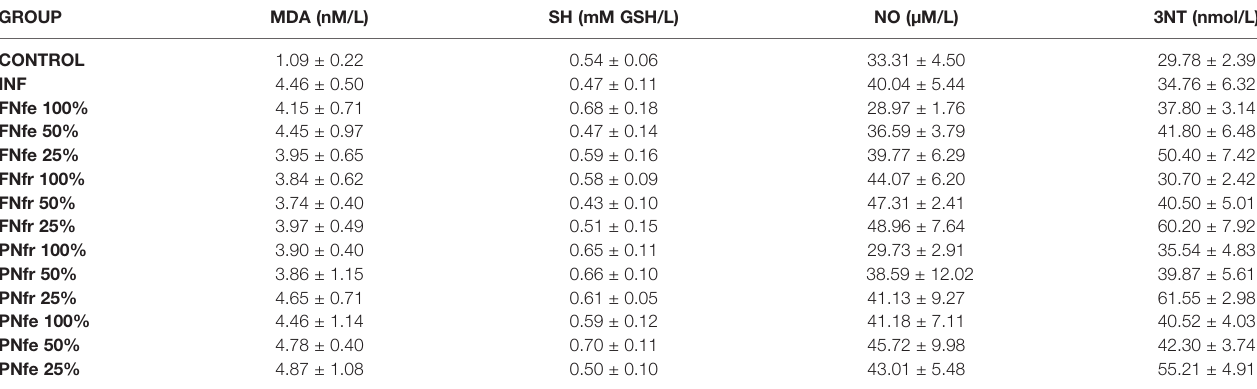
TABLE 3 | In vivo antioxidant speci fi c tests results.